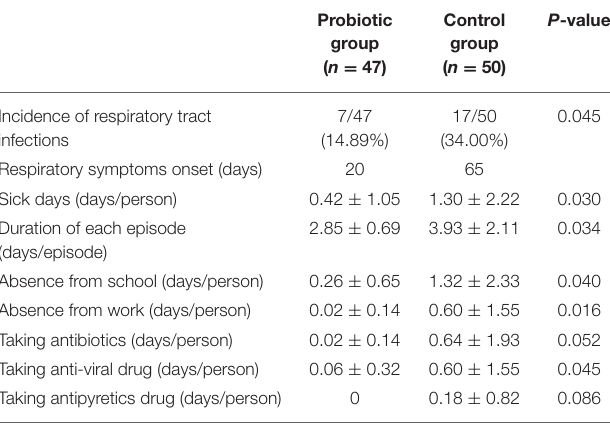
TABLE 2-1 | The clinical outcomes during the 30 days of oropharyngeal probiotic intervention among children with RRTi in cold season. Probiotic